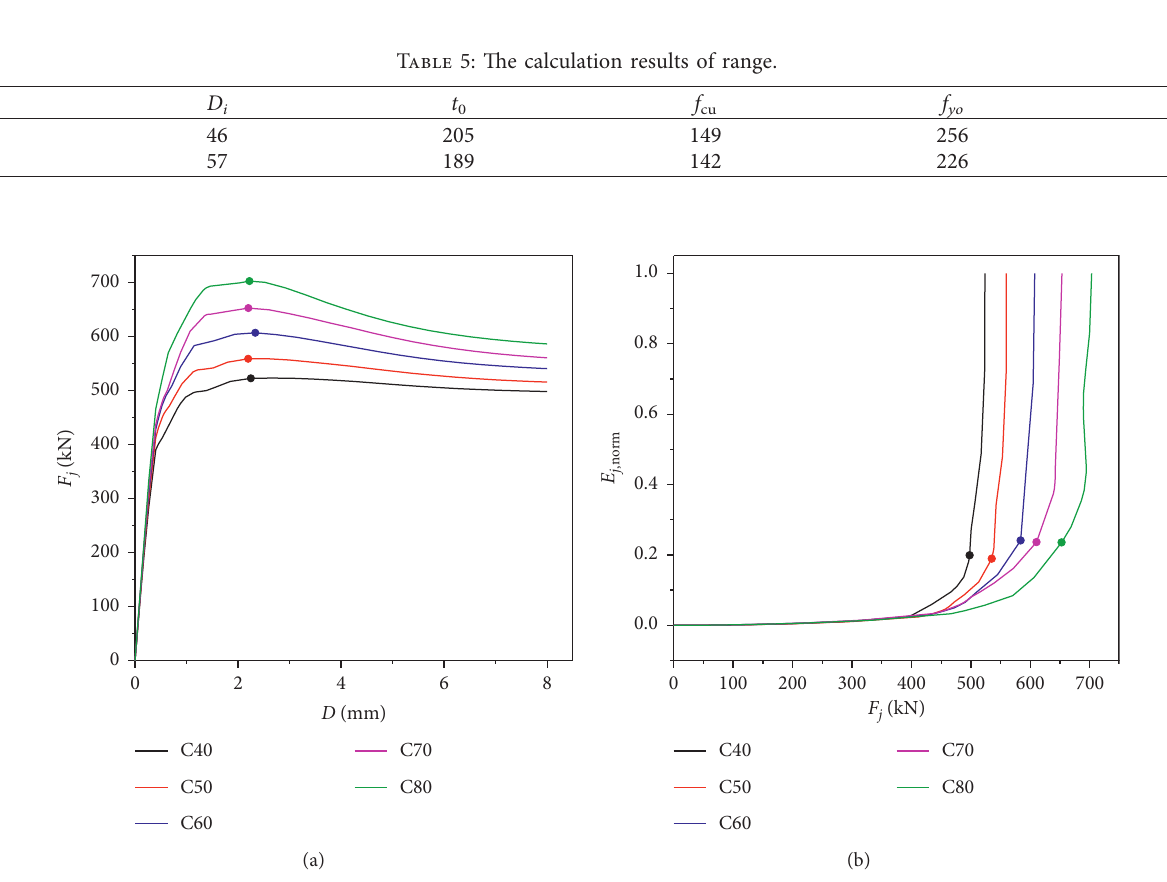
− F j, norm j curves of different concrete